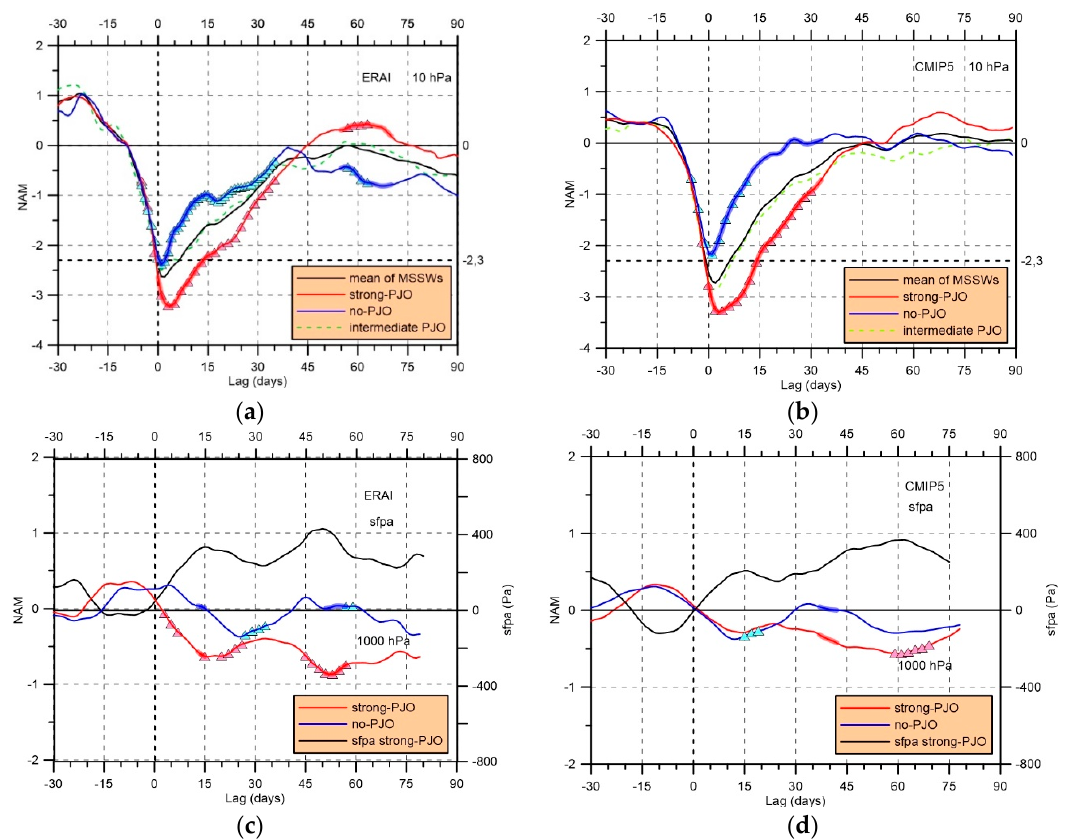
Figure 3. Evolution of northern annular mode (NAM) for ERA ‐ Interim ( a,c ) and for CMIP5 ‐ ESM ‐ LR ( b,d ) at 10 hPa ( a,b ) and 1000 hPa ( c,d ) for strong ‐ PJO (red) and non ‐ PJO (blue). Black line in ( a,b ) indicates mean MSSW event behavior and green dashed line indicates intermediate ‐ PJO events. The black line in ( c,d ) shows the polar surface pressure anomaly (SFPA) for strong ‐ PJO. All quantities in panels ( c,d ) show a 21 ‐ days running mean. Thick lines indicate statistically significant differences of 95% confidence between strong ‐ PJO and non ‐ PJO events. Triangles indicate statistically significant differences from climate mean with a confidence of 95%. NAM, at each pressure level, is the polar cap integrated geopotential height anomaly normalized by its mean standard deviation.